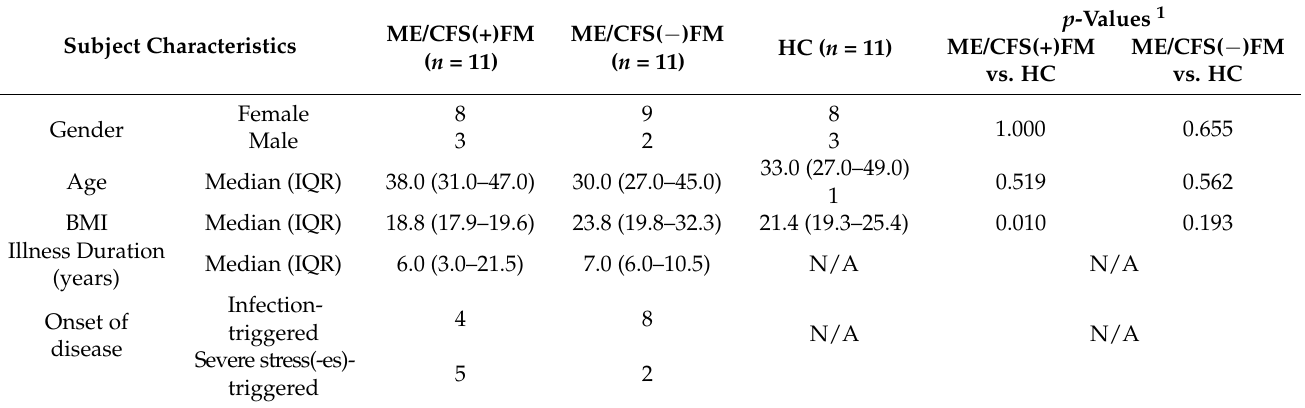
Table 2. Study population characteristics. BMI—body mass index, FM—fibromyalgia, HC—heathy controls, IQR—interquartile range, ME/CFS—myalgic encephalomyelitis/chronic fatigue syndrome.